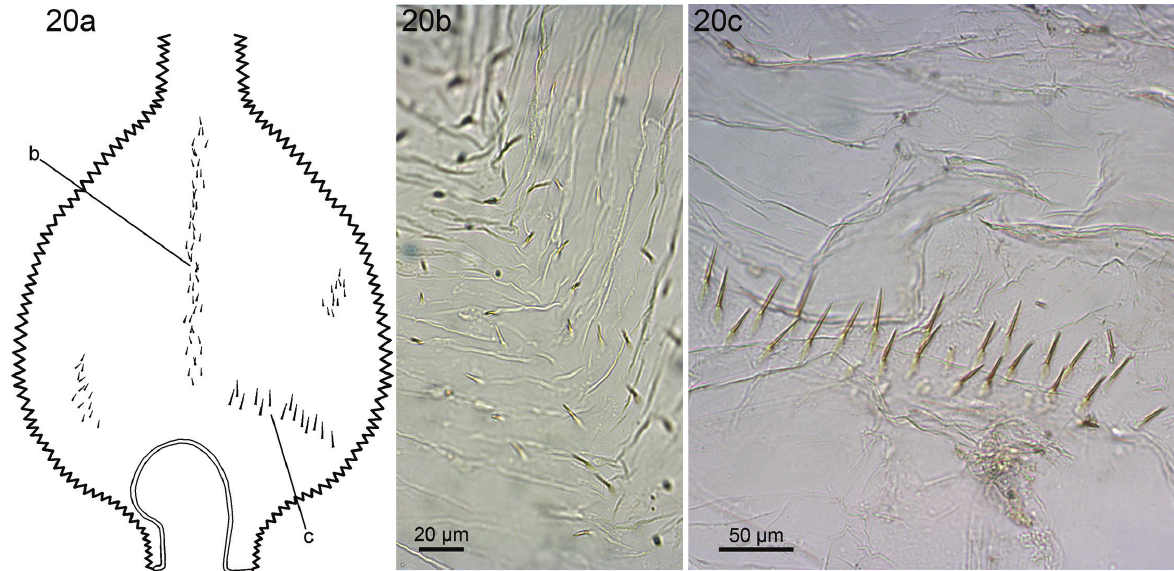
Figure 20. Paracurvitermes manni . (a) Schematic drawing of P1 showing arrangement of spines. (b, c) Photomicrographs: (b) Detail of the middle distal row of spines; (c) Transverse row of aciculiform spines in